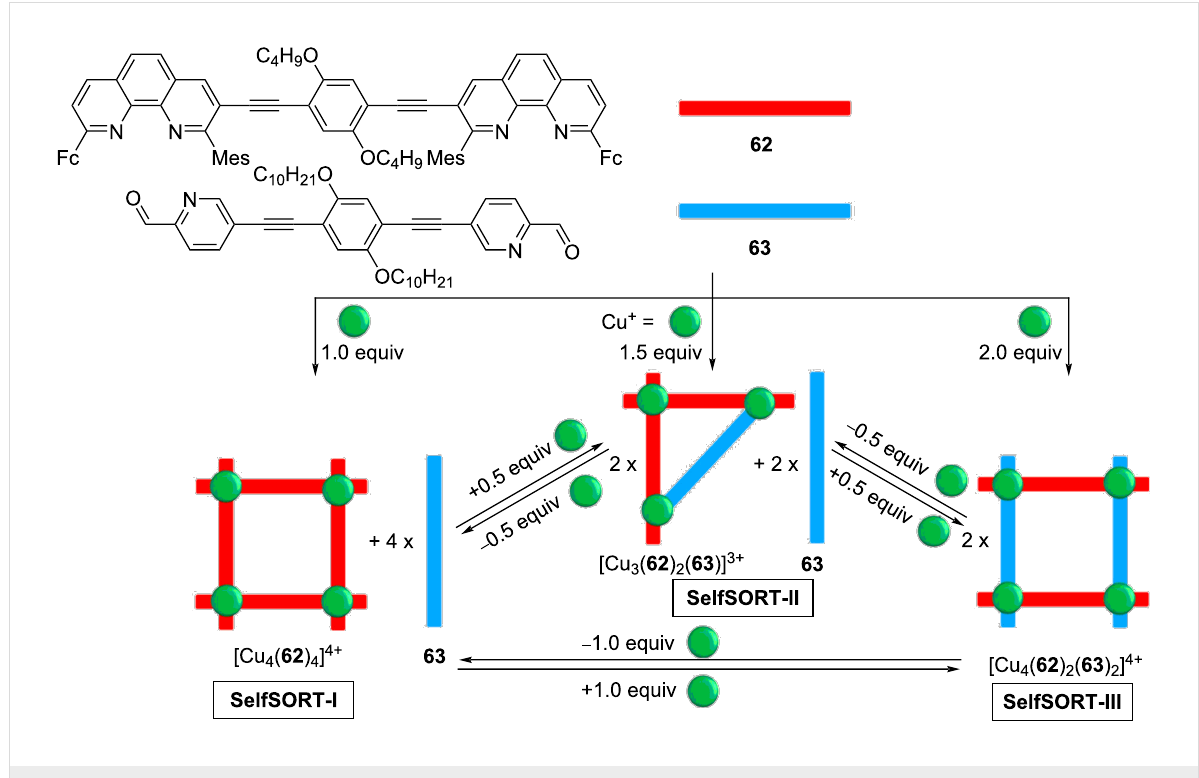
Figure 17: Fully reversible multiple-state rearrangement of metallosupramolecular architectures depending upon copper(I) stoichiometry. Repro- duced from [65].